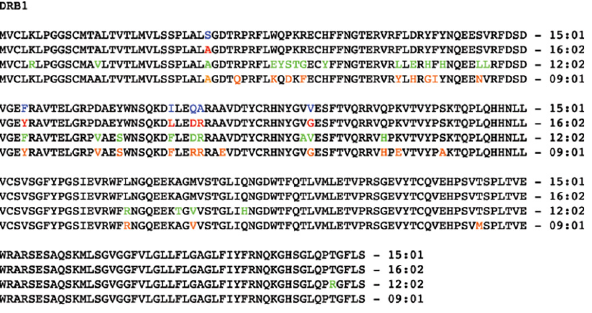
Fig 1. Amino acid sequence alignment of various HLA-DRB1 subtypes.